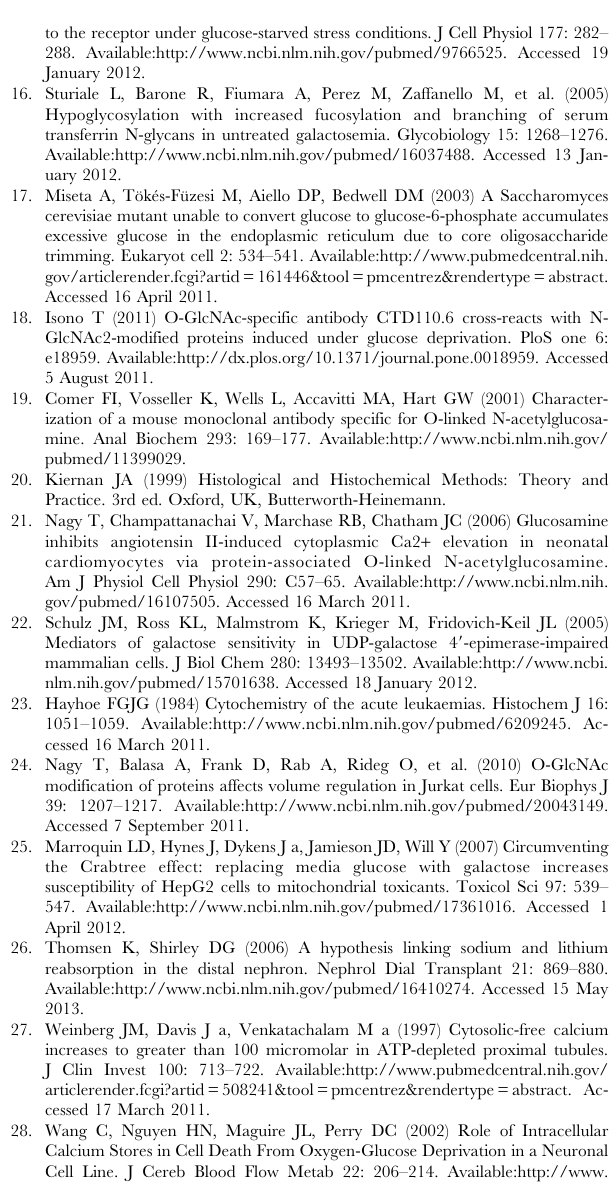
Figure S2 Densitometric analysis of CTD110.6 and WGA blots shown in Figure 7. Densitometry of western-blots using CTD110.6 antibody and peroxidase-conjugated lectin (WGA) staining. Jurkat cells were previously incubated for 48 hours in 5 mM glucose, 5 mM galactose or hexose-free media, supplemented with either 0, 2.5 or 10 mM lithium. ( A ) Densitometric analysis of the total CTD110.6 staining. ( B ) Densitometry of the total WGA staining. ( C ) Densitometric analysis of the CTD110.6 positive band indicated in Figure 8A by the arrow. ( D ) Densitometric analysis of the WGA positive band indicated in Figure 8B by the arrow. Data are means 6 SD from 3 independent experiments after normalized for total protein staining. *P , 0.05 vs. 5 mM glc.